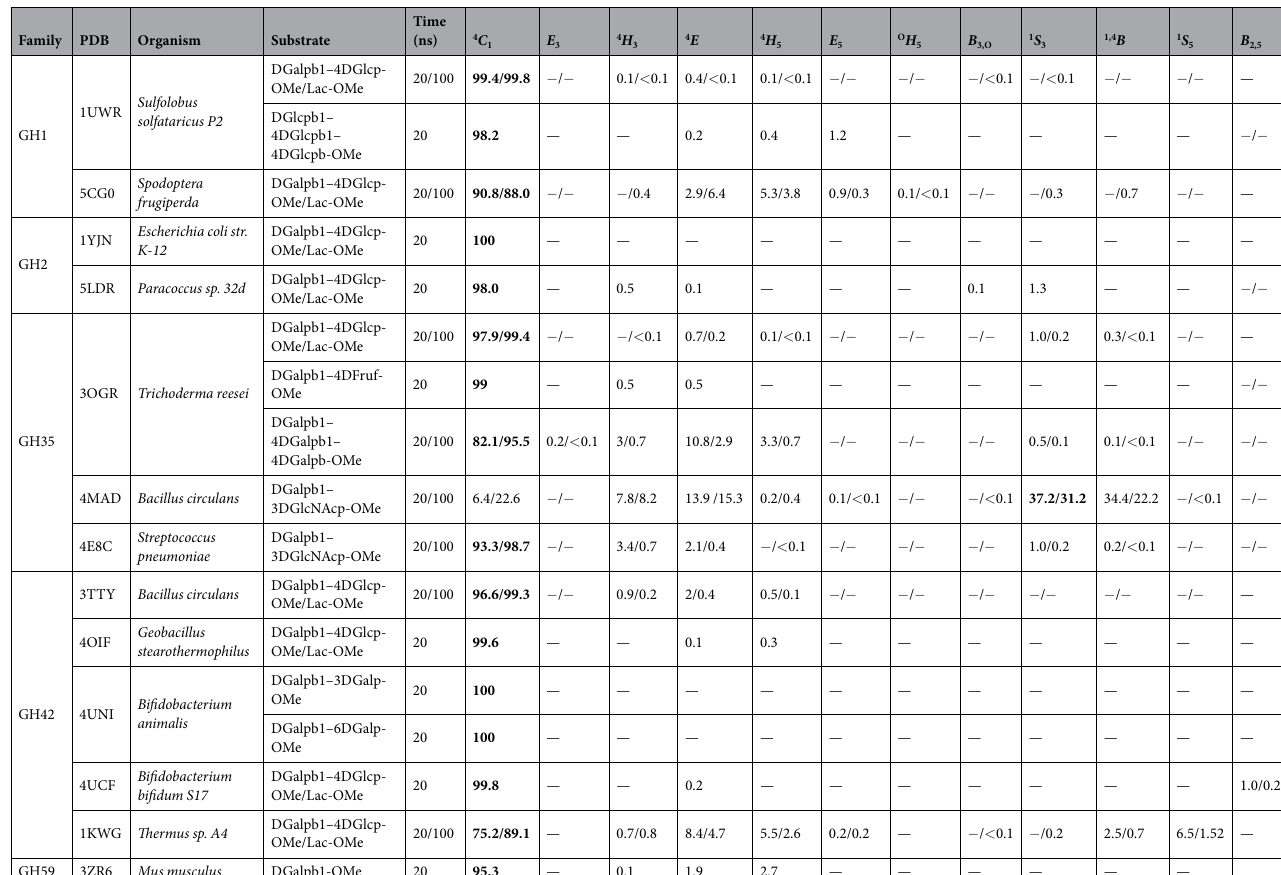
Table 1. Relative puckering distributions at subsite − 1 identified in clan GH-A β -galactosidases during MD simulations. Percentage of each ring conformer shape attained by the non-reducing end residue at subsite − 1 sampled in 1000 or 5000 time steps throughout 20 or 100 ns MD simulations, respectively, for different carbohydrate substrates against targeted β -galactosidases from clan GH-A. The different enzymes are identified by a reference PDB code and by species. The non-reducing end residue is a β -D-galactopyranosyl residue, excepting for a single substrate were it is a β -D-glucopyranosyl residue, shown in bold. The most abundant ring conformer for each MS simulation is highlighted in